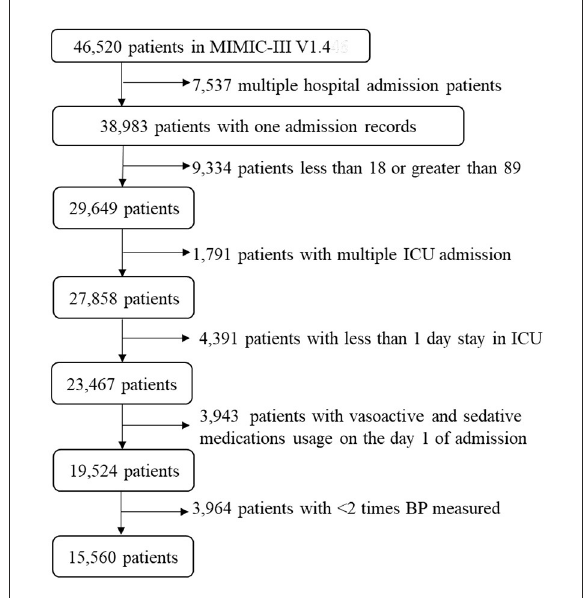
FIGURE1 A flow chart of recruiting study participants. A total of 15,560 patients were included in this study. ICU, intensive care unit; BP, blood pressure; MIMIC-III, Multiparameter Intelligent Monitoring in Intensive Care